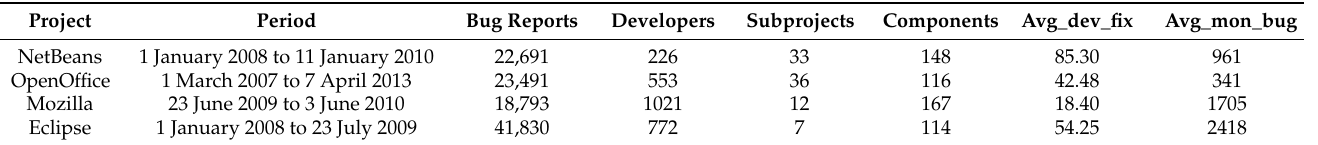
Table 1. Statistics of collected bug reports.